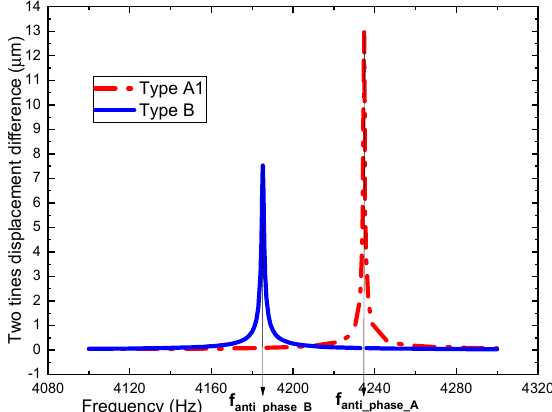
ff erential displacement of two tines of types A1 and Figure 8. Differential displacement of two tines of types A1 and B. Figure 8. Di